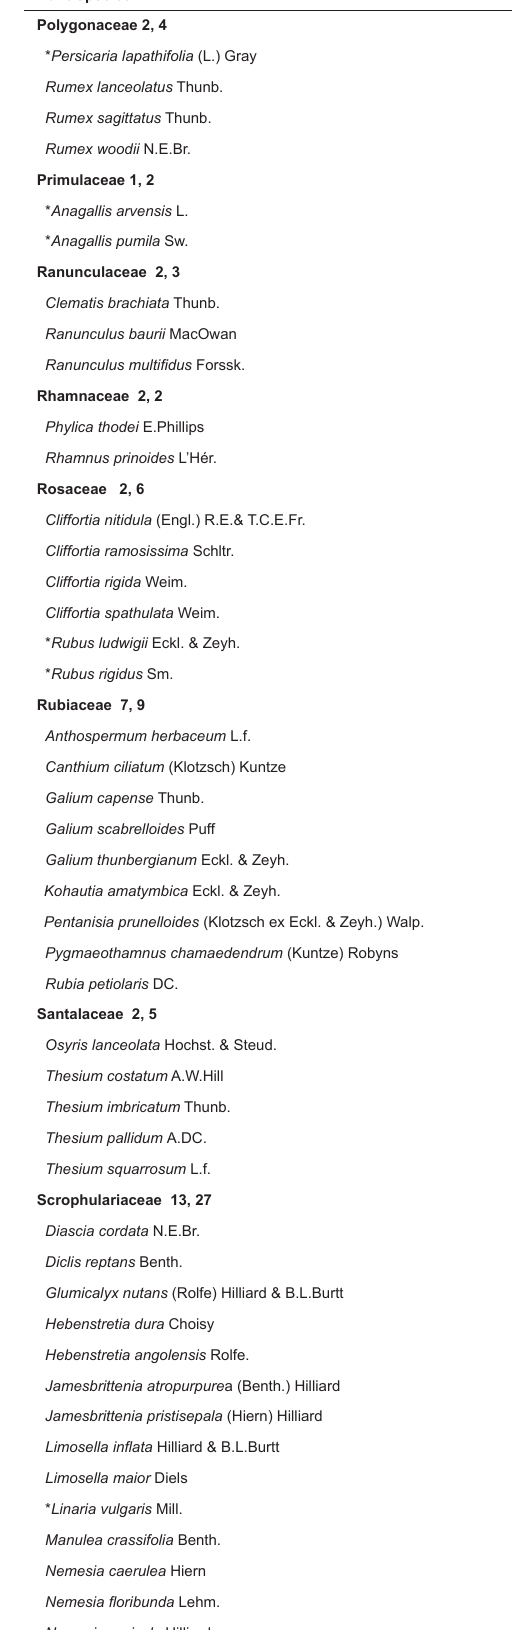
TABLE 4 (Continues...) Comprehensive list of Angiosperms, listed first by monocotyledons and then dicotyle - dons. The list includes 86 Families, 293 genera and 652 species Plant